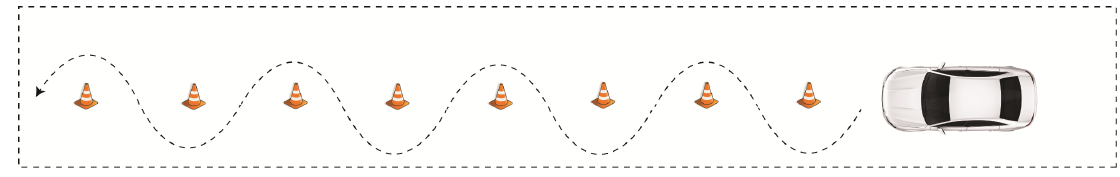
Figure 1. Scheme of the slalom maneuver performed by the vehicle.